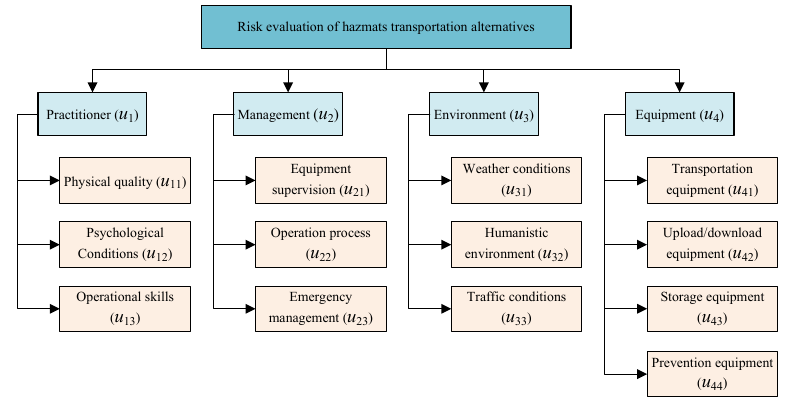
Figure 2. Risk evaluation criteria of HazMat transportation